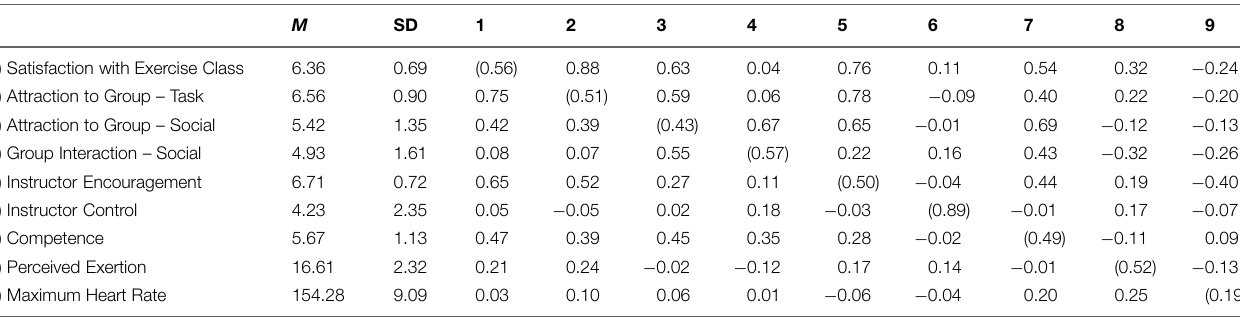
Intraclass correlation coefficients representing the proportion of between-person variance appear in parentheses on the diagonal of the correlation matrix. Coefficients below the diagonal are correlations across classes and people. Coefficients above the diagonal represent correlations of within-person means. M = sample-level mean, SD = sample-level standard